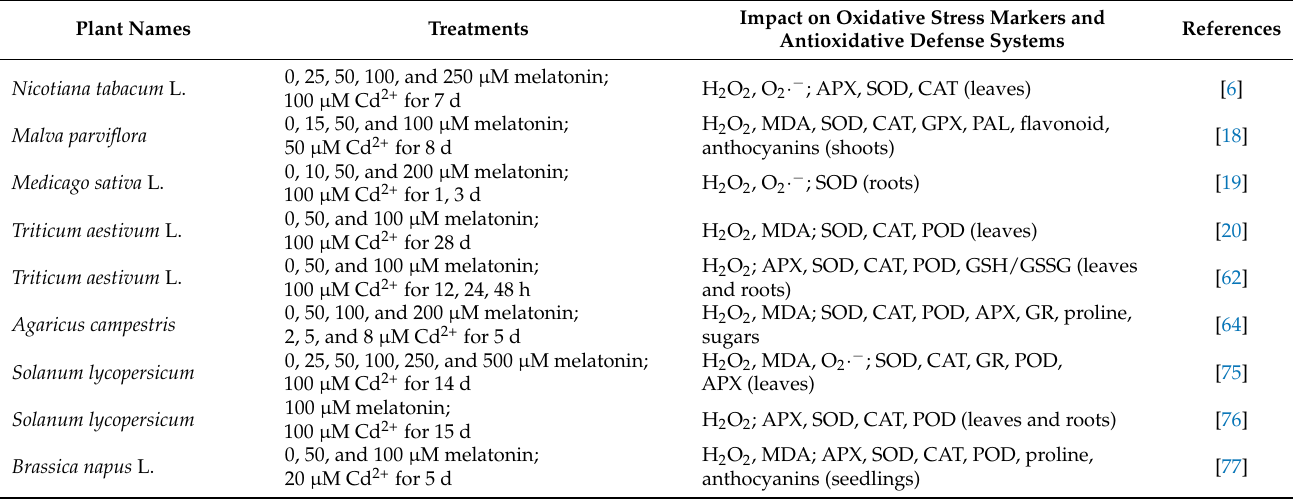
Table 2. Summary table explaining the impacts of melatonin on Cd-induced oxidative stress. Plant Names Treatments